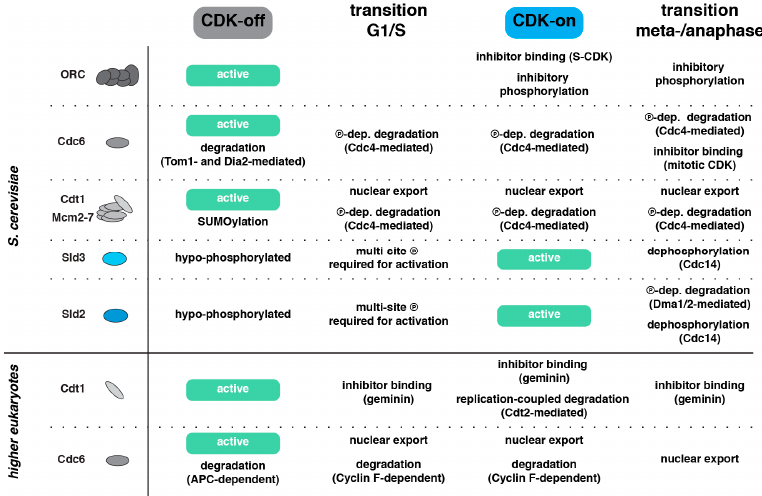
Figure 3. Mechanisms preventing over-replication. Summary of molecular mechanisms inhibiting licensing or firing at specific cell cycle phases (CDK-off or CDK-on) and specifically at the G1/S transition and the metaphase-to-anaphase transition. These inhibitory mechanisms are likely candidates to generate a temporal order in the activation/inactivation of licensing and firing factors and to thereby counteract sporadic over-replication at cell cycle transitions and limit replication to once per cell cycle.